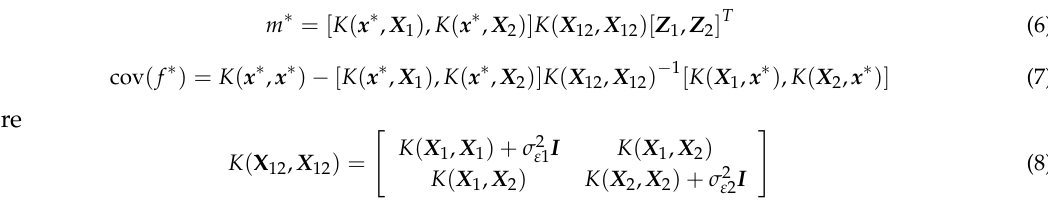
T able 1 Geometric characteristics of 8 base kernel functions.